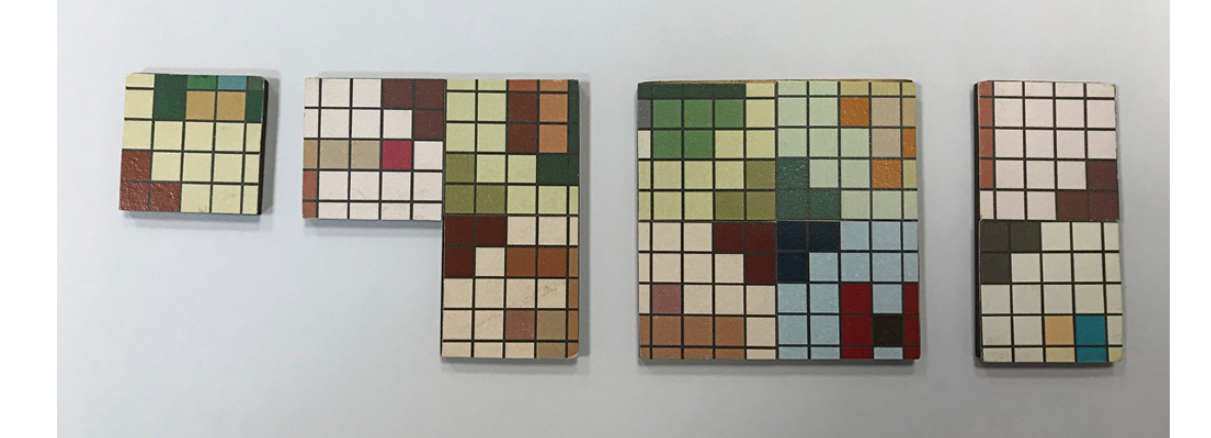
Figure 2. The 4 different types of puzzle tiles and the pixel graphics on the tiles.